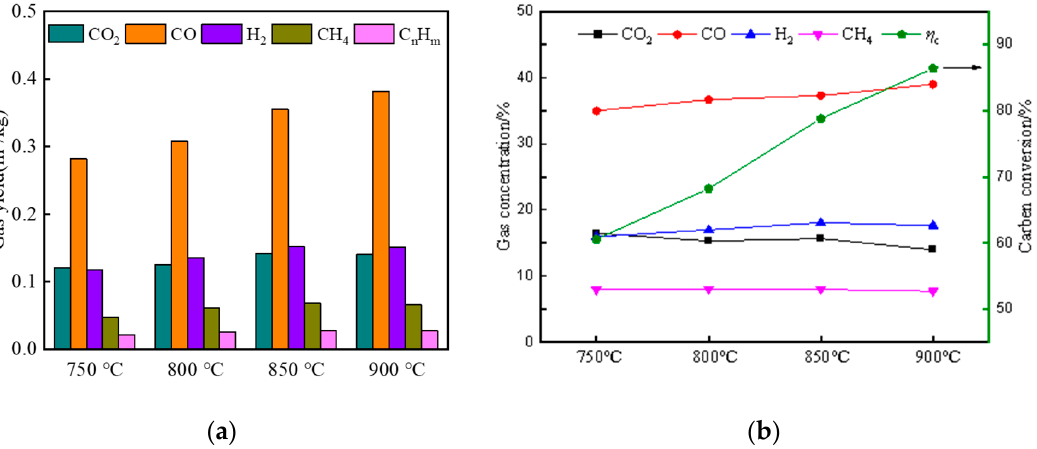
Figure 6. The effects of reaction temperature upon ( a ) the gas yield and ( b ) the gas concentrations and carbon conversion during wood waste gasification.